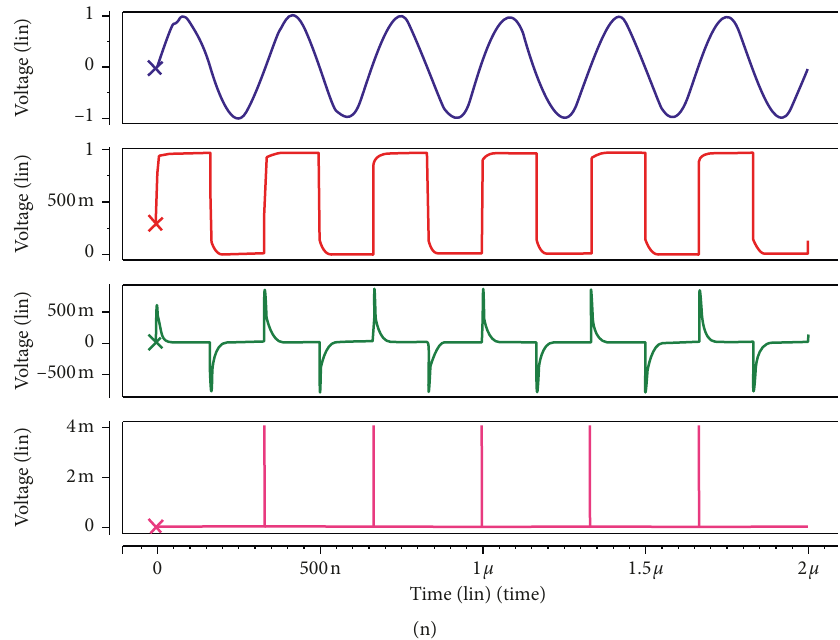
Figure 6: Input-output waveforms of different applications. (a) Noninverting amplifier. (b) Inverting amplifier. (c) Summer. (d) Subtractor. (e) Differentiator. (f) Integrator. (g) Half-wave rectifier. (h) Full-wave rectifier. (i) Clipper. (j) Clamper. (k) Inverting comparator. (l) Noninverting comparator. (m) Peak detector. (n) Zero crossing